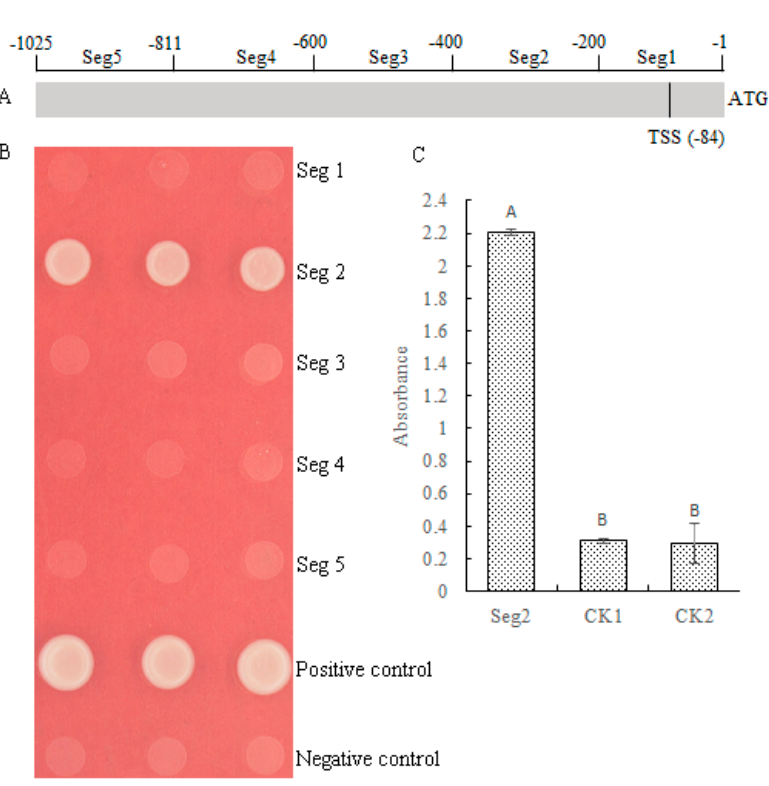
Figure 6. ( A ) MePHD1 binding to the region of − 400 to − 201 in MeAGPS1a promoter. Distribution of five segments in the MeAGPS1a promoter. TSS: Transcription start site. ATG: Initiation codon. ( B ) Activation of MeAGPS1a , promoter in yeast, by MePHD1. Yeast cells carried pGADT7-MePHD1+p(Seg1 to Seg5)-AbAi, positive control (pGADT7-Rec53+p53-AbAi), and negative control (pGADT7-MePHD1 + pAbAi), were grown in SD/-Leu selective medium with 50 ng/ml AbA, for 3 days at 30 °C; the three dots in each line mean three replications. ( C ) MePHD1 interacts with the Seg2 by DPI-ELISA assay. Seg2: Double-strand biotinylated Seg2 DNA probe + purified MePHD1 fusion protein; CK1: Double-strand biotinylated Seg2 DNA probe + tagged protein ProS2; CK2: Purified water + purified MePHD1 fusion protein. Error bars represent the SD of four technical replicates, the significant difference was assessed by ANOVA, A,B means the significant difference at p < 0.01 level.